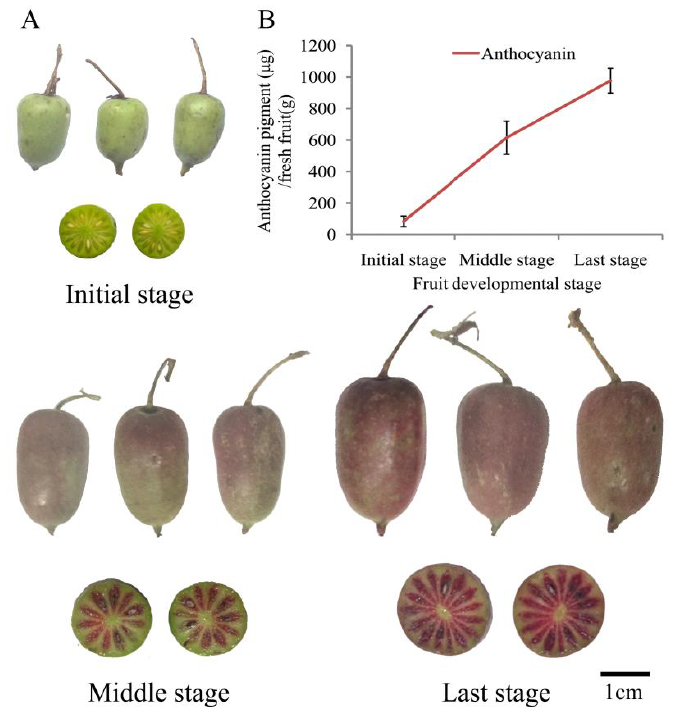
Figure 1. The anthocyanin pigment during fruit development of A. arguta . ( A ) Developmental stages of A. arguta fruit. (bar = 1 cm). ( B ) Anthocyanin pigment and concentration in fruit during three developmental stages. Table 1. Summary of sequence assembly after